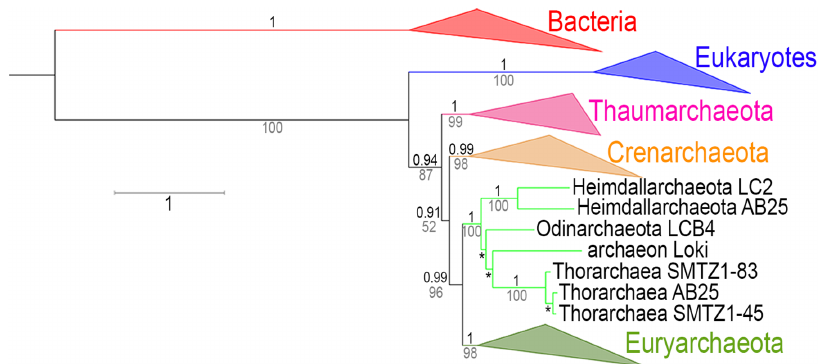
Fig 8. RNA polymerasephylogeny with the Asgards archaea. Tree representingthe combined phylogenies obtainedin ML (LG model + Γ 4) and Bayesian inference (CAT-GTR model) analysesof the two largest RNA polymerasesubunitsafter inclusionof the Asgards archaeain the dataset (detailedtrees in S36 and S37 Figs). Bacterial and eukaryoticsequencesare indicatedin red and blue, respectively. Among the Archaea, Thaumarchaeota, Crenarchaeota, and Euryarchaeotaare indicatedin pink, orange, and olive-green respectively. Values over the branches (in black) correspondto the posterior probabilities (PP) of the corresponding nodes obtained from Bayesianinferences, while the values belowthe branches (in grey) representsupports calculatedby non parametricbootstrap (BS) from the ML analysis. Branch lengthsin this tree are derived from the tree obtainedfrom the Bayesianinference(S37 Fig), and the scale-barrepresents the averagenumber of substitutions per site. From base to tips, the three * correspond to 0.95/53, 0.92/61, and 1/100,